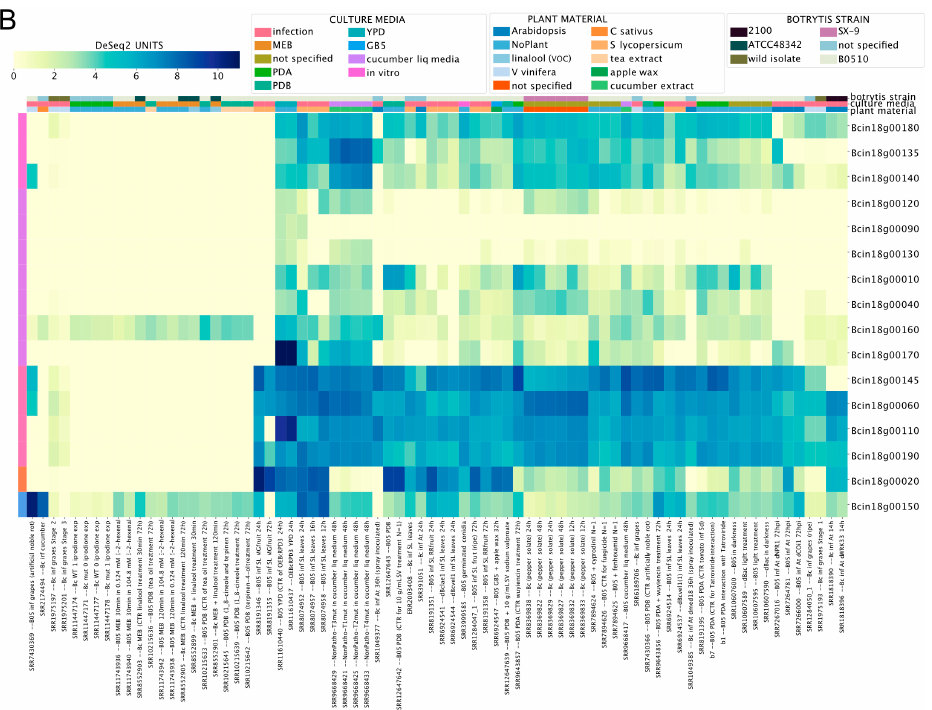
Figure 6. Expression levels of transcripts on mini chromosomes 17 ( A ) and 18 ( B ) of B. cinerea . Both heatmaps indicate mRNA levels specified by a scale from yellow to dark blue (low or high expres- sion, respectively). Both heatmaps indicate mRNA levels and experimental conditions, as described in former